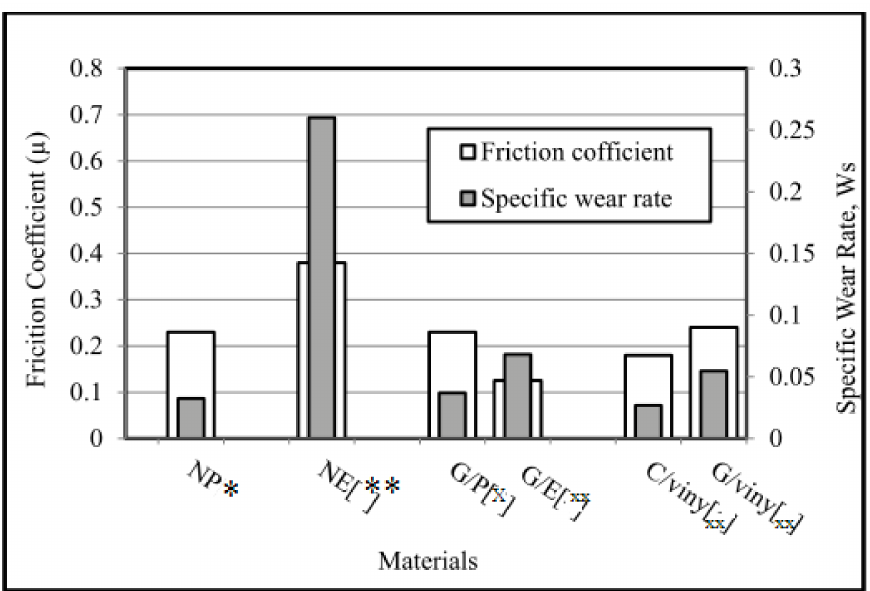
Figure 12. SWR and frictional behaviour of several composites, note that * is ref. No. [15], ** is ref. No. [18], x is ref. No. [1], and xx is ref. No.